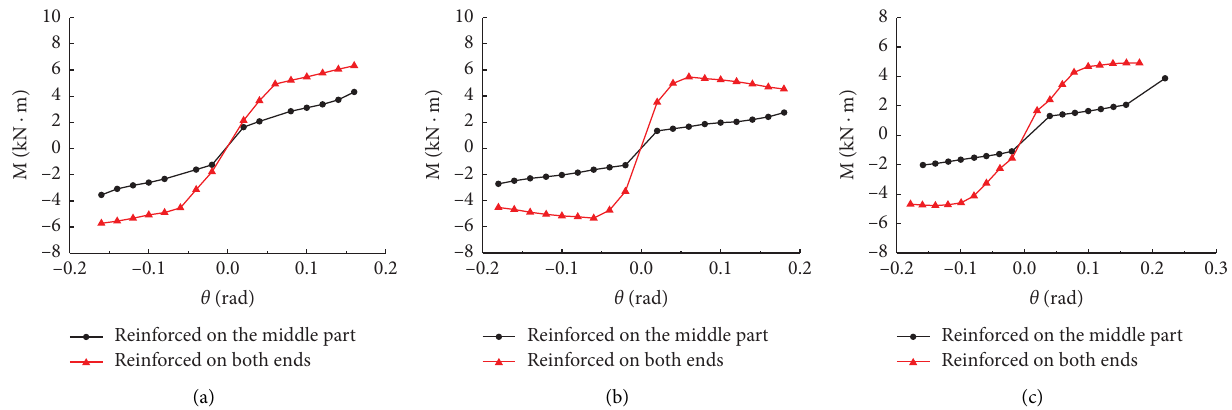
Figure 23: Comparison of moment-rotation backbone curves of joints at diferent positions of reinforcement by fat steel strips: (a) Tou mortise-tenon joints. (b) Ban mortise-tenon joints. (c) Dovetail mortise-tenon